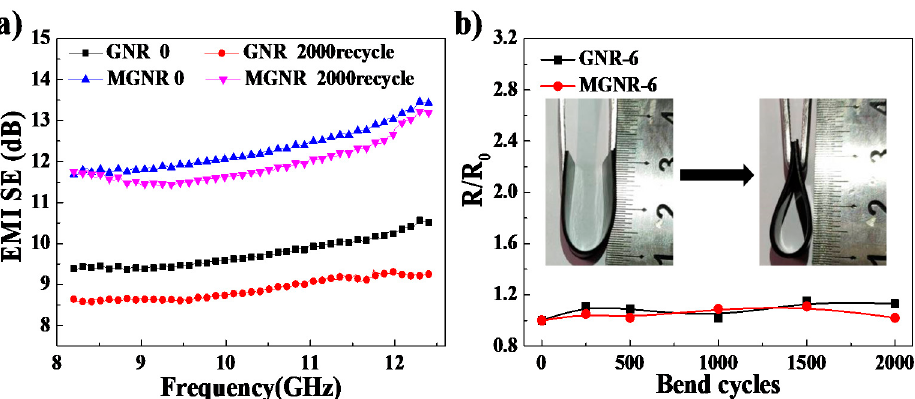
Figure 9. ( a ) The EMI SE of the MGNR-6 and GNR-6 composites before and after bending for 2000 cycles; and ( b ) normalized electrical resistance as a function of bend cycles for MGNR-6 and GNR-6 composites (the thickness was 0.6 mm).